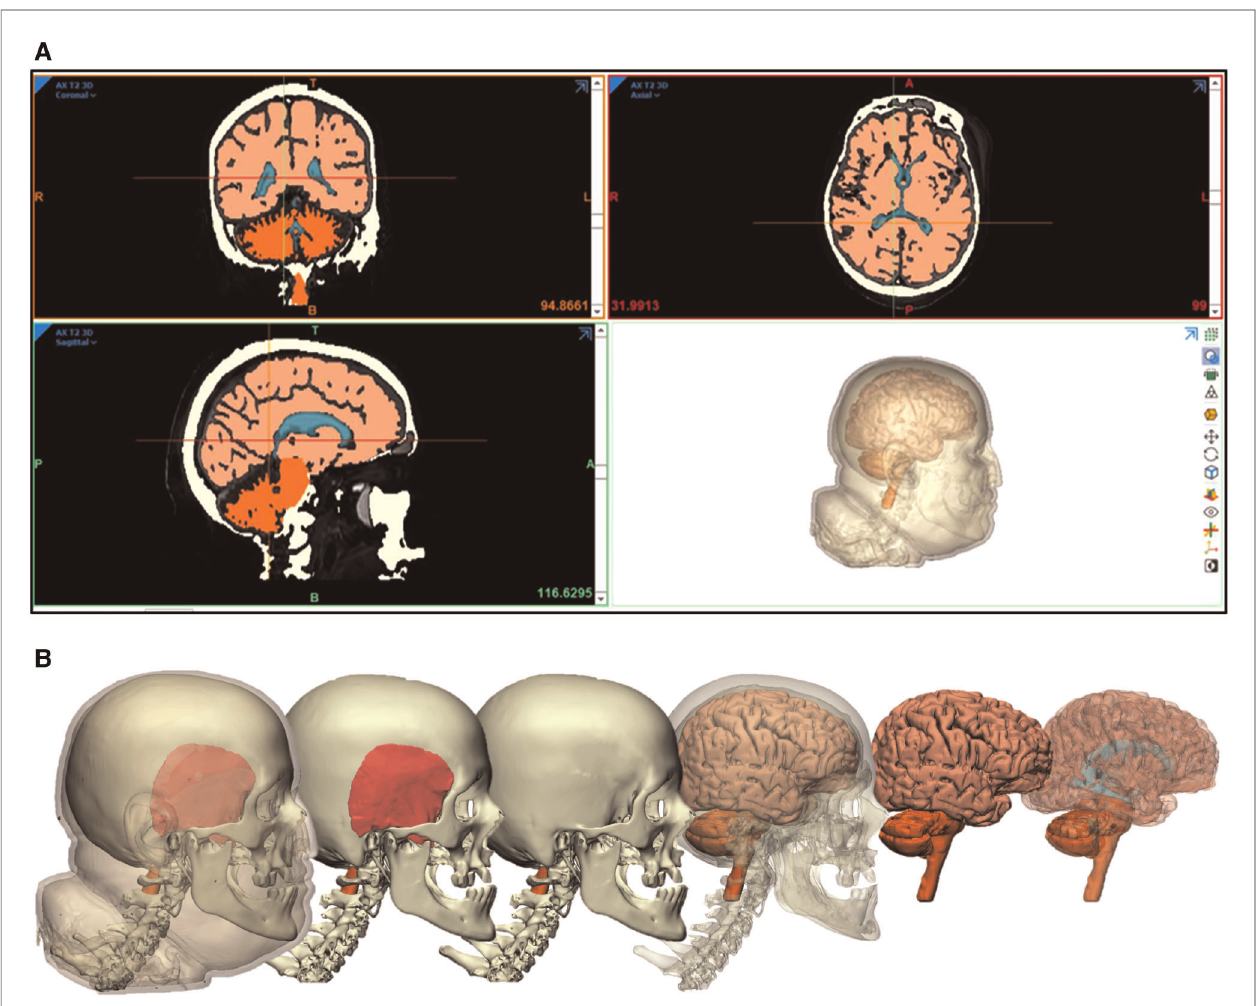
FIGURE 2 | Segmentation and rendering process. ( A ) Neuroimaging data used for 3D rendering of segmented anatomical structures. ( B ) 3D rendering of segmented anatomical structures. Used with permission from Barrow Neurological Institute, Phoenix, Arizona